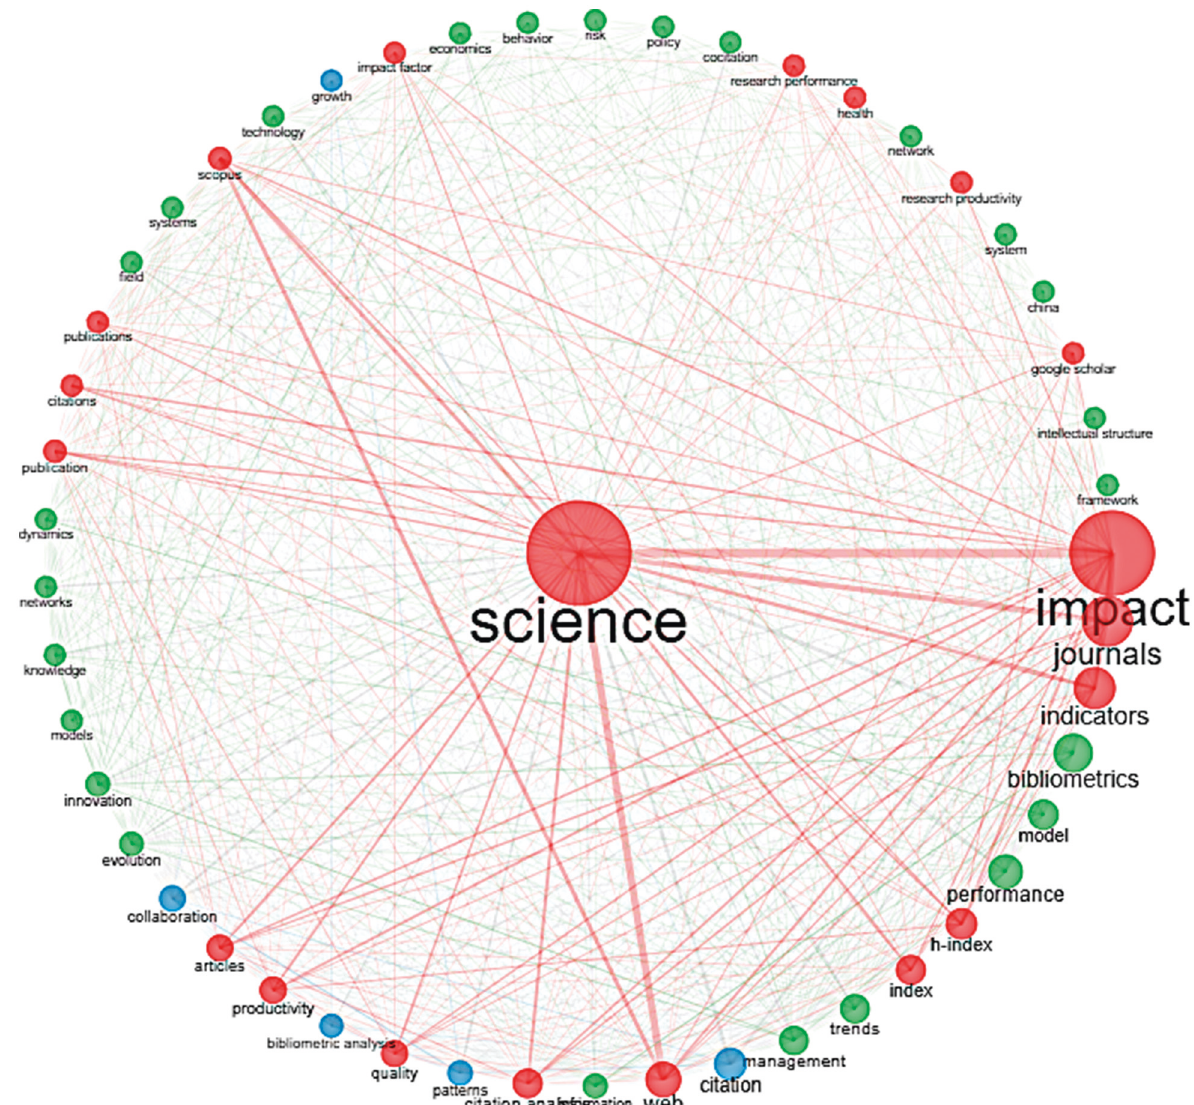
Figure 12: Keywords cooccurrence